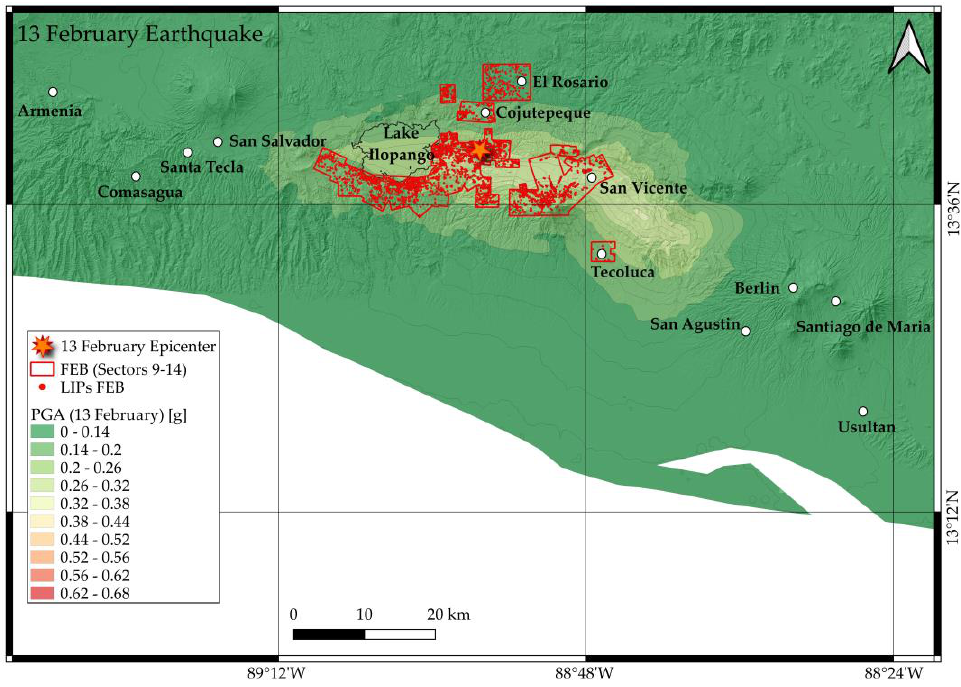
Figure 7. PGA values of the seismic event of 13 February 2001 and LIPs of the landslides triggered in the FEB study areas.